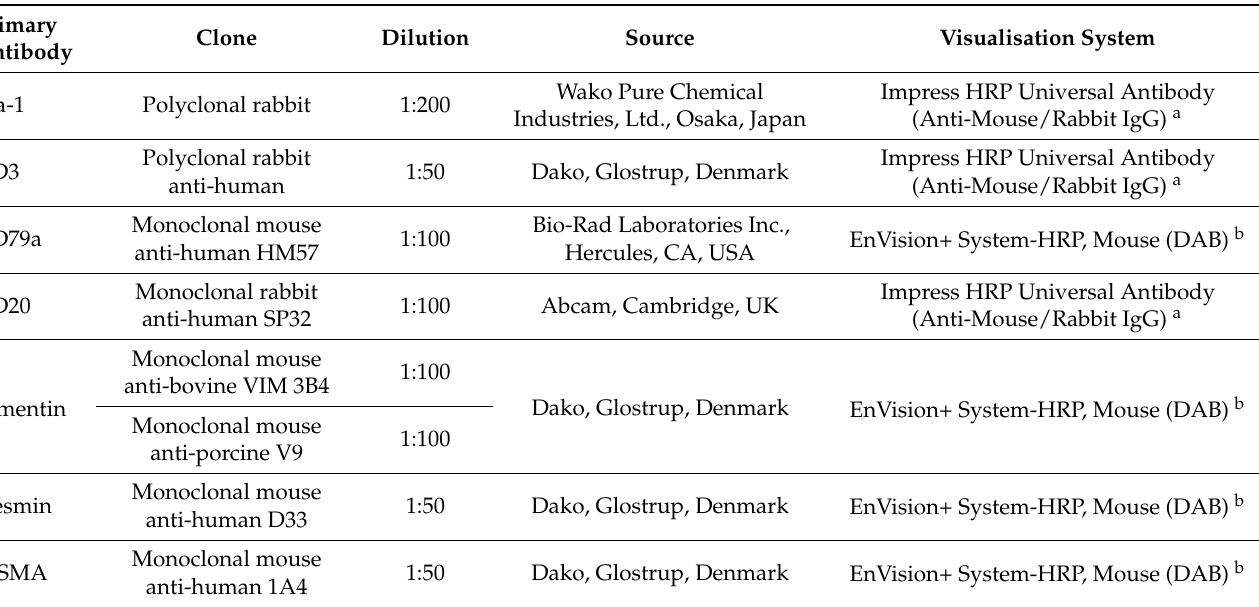
Table 1. Primary antibodies and visualisation systems used in immunohistochemical examination.